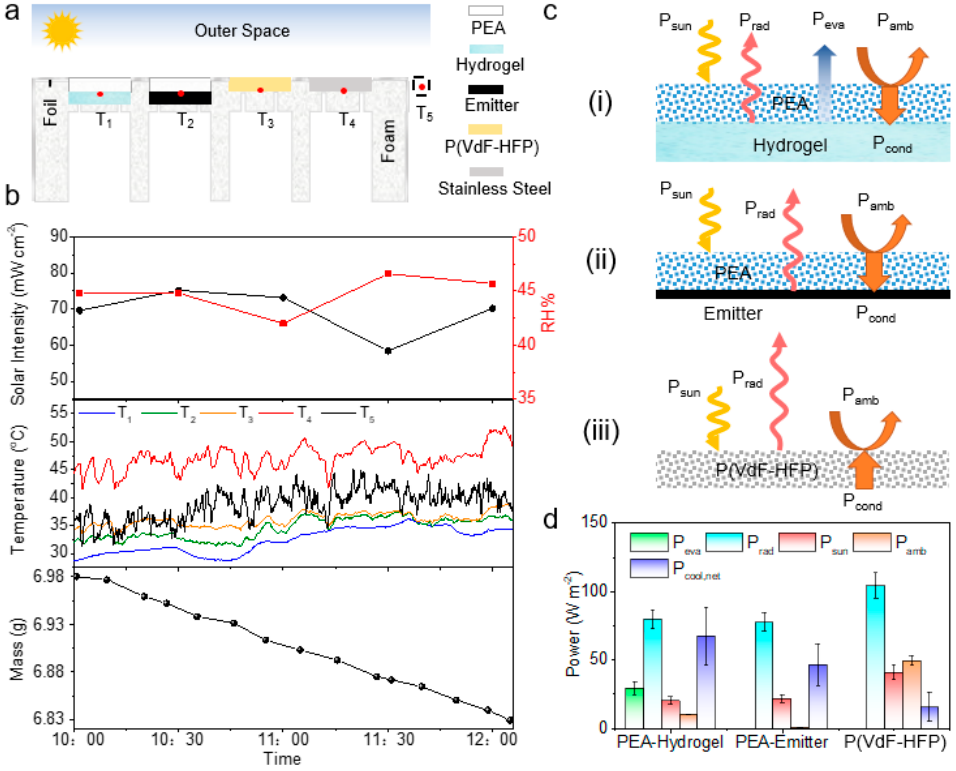
Figure 3. Cooling performance of the PEA and hydrogel membrane. ( a ) Schematic of the experimental setup. ( b ) Outdoor experiment from 10:00 to 12:10 14 Jun 2022 in Wuhan, China. Top panel: real-time solar intensity and environment humidity; middle panel: temperatures of the PEA and hydrogel sample (blue line, T 1 ), the PEA and emitter sample (green line, T 2 ), the P(VdF-HFP) sample (orange line, T 3 ), the stainless steel substrate (red line, T 4 ) and the environment (black line, T 5 ); bottom panel: mass changes of the hydrogel (4 cm × 4 cm × 4 mm, 30 wt% LiBr). ( c ) Heat transfer models of the PEA and hydrogel ( i ), the PEA and emitter ( ii ) and the P(VdF − HFP) ( iii ). ( d ) Average evaporative, radiative, net cooling, absorbed solar, and ambient convection power of the PEA and hydrogel sample, the PEA and emitter sample, and the P(VdF-HFP)